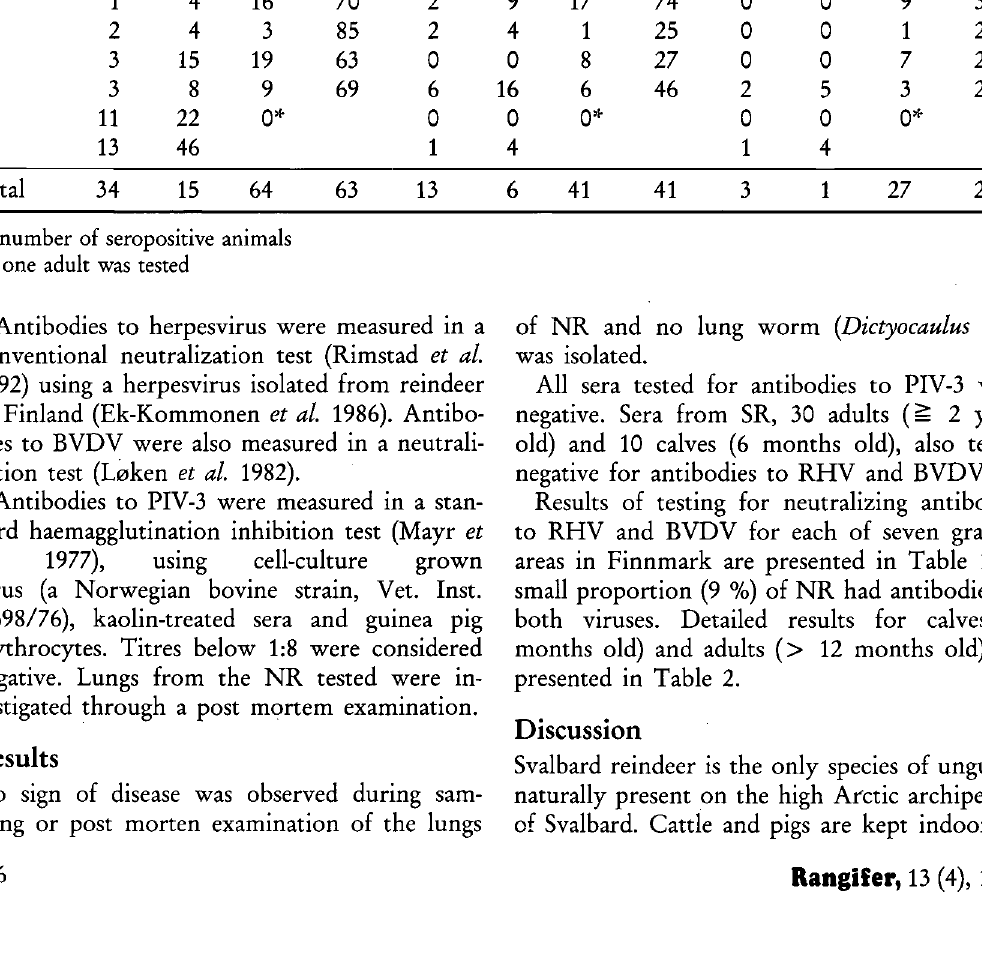
Table 2. Comparison of the proportion (%) of adult and calf Norwegian reindeer from seven pasture districts in Finnmark which tested seropositive for antibodies to reindeer herpesvirus and bovine virus diarrhoea virus